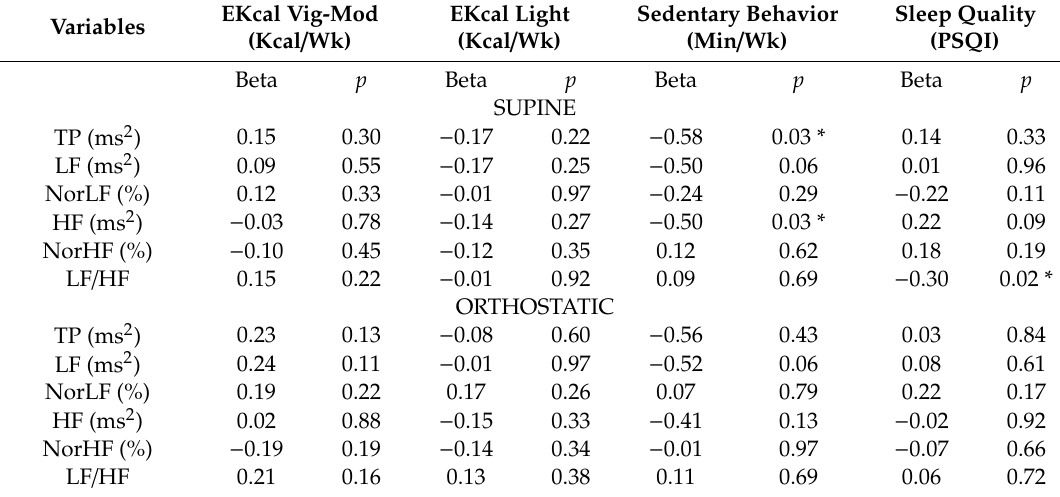
Table 4. Standardized regression coefficient (Beta) and significance ( p ) values for each variable of crude model adjusted with covariates (Age, BMI and Percentage fat mass) in relation to the heart rate variability indices in the supine and orthostatic positions.